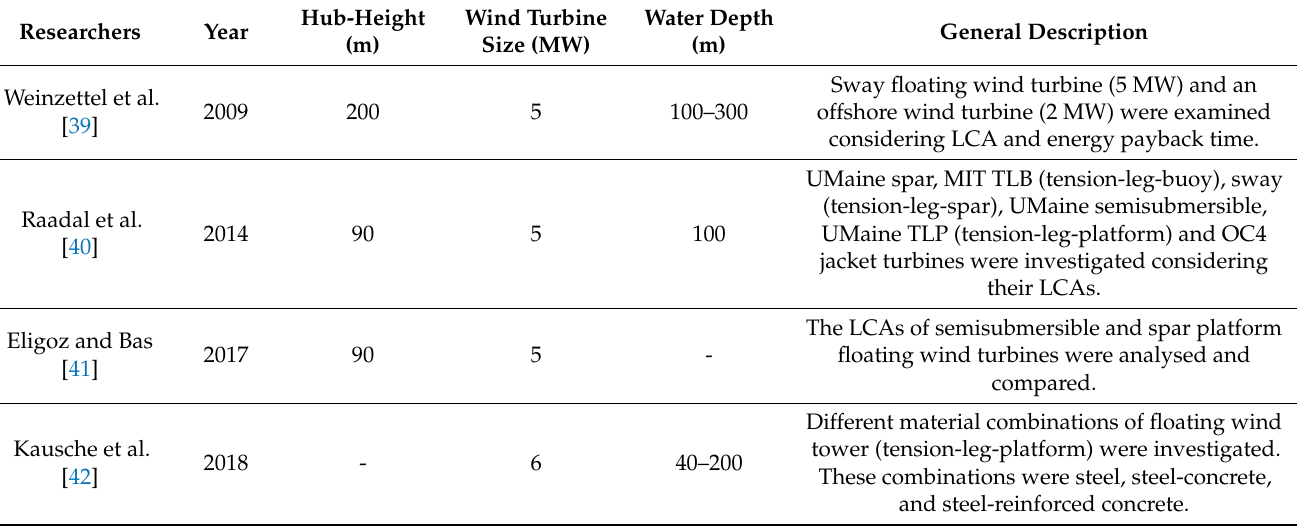
Table 2. Literature on LCA of floating wind turbine